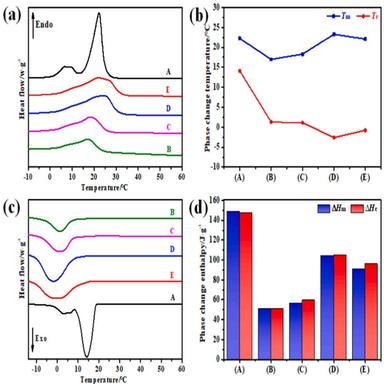
(a) DSC heating curves, (b) phase change temperatures, (c) DSC cooling curves and (d) phase change enthalpies of MicroPCMs with different BS/HMDI/CS mass ratios: (A) BS, (B) 6.25:11.5:1, (C) 12.5:11.5:1, (D) 25:11.5:1 and (E) 37.5:11.5:1.